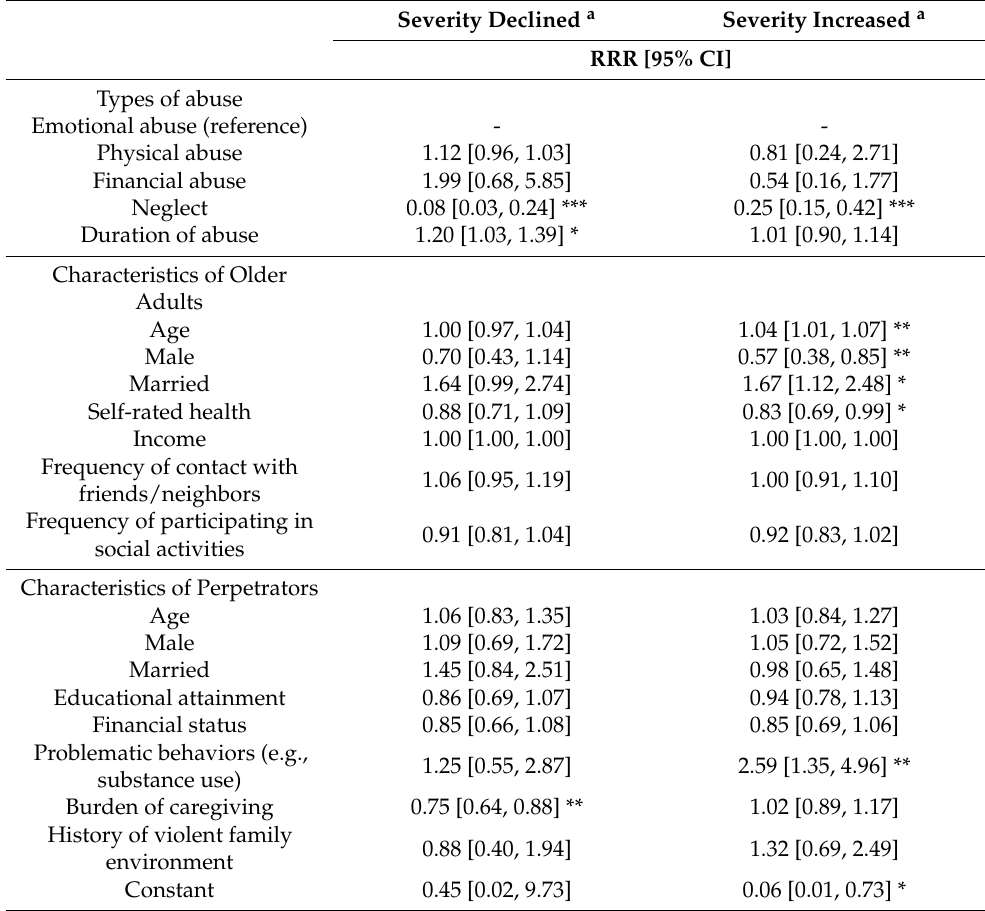
Table 2. Factors associated with perceived change in severity of abuse (N =